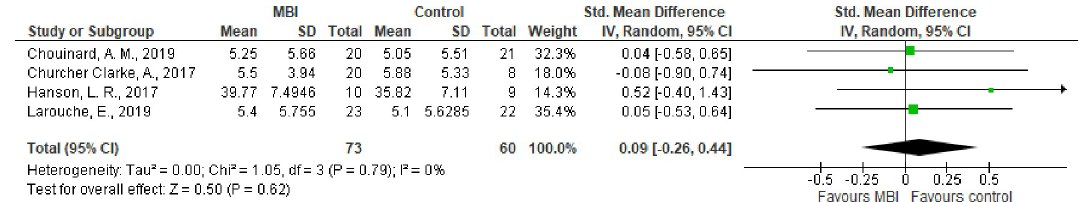
Fig 3. Forest plot of comparison: Anxiety symptoms, MBI versus control after 6 to 10 weeks from the beginning of the intervention.